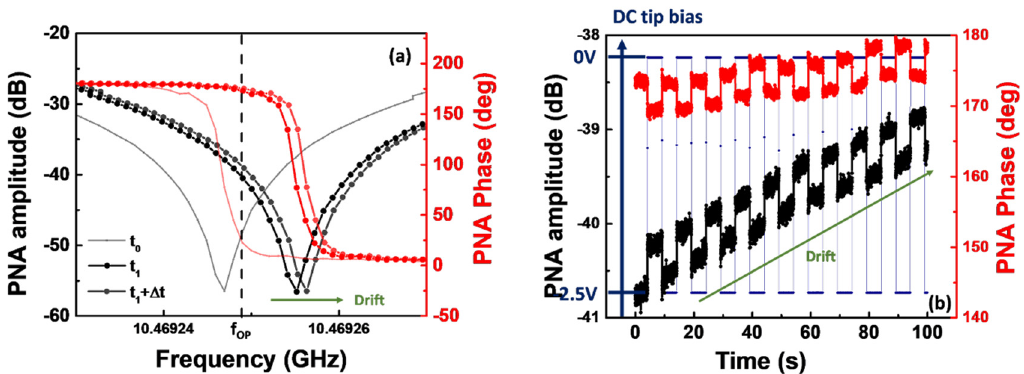
Figure 2. ( a ) PNA Amplitude and Phase spectra captured at t 0 . The spectra at t 1 and t 1 + ∆ t corresponding to the interferometric response prior to and after the capture of time profiles displayed in ( b ) are reconstructed from the spectra at t 0 taking only into account the drift of f 0 evaluated ~1.7 Hz s − 1 ( b ) Variations of PNA Amplitude and Phase upon DC gate bias for f OP ~10.4925 GHz. The applied DC tip bias is also shown associated with a vertical blue scale.